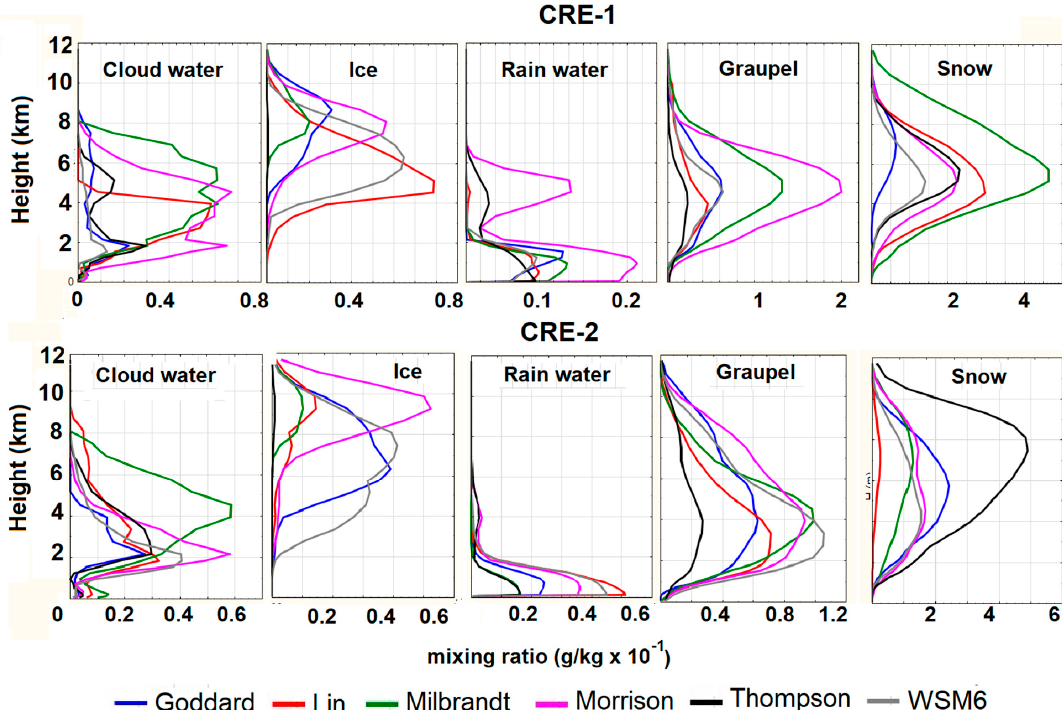
Figure 12. Average vertical profile of hydrometeors simulated by WRF model microphysics schemes for CRE1 (upper panels) and CRE2 (lower panels) for the six tested parameterization schemes.